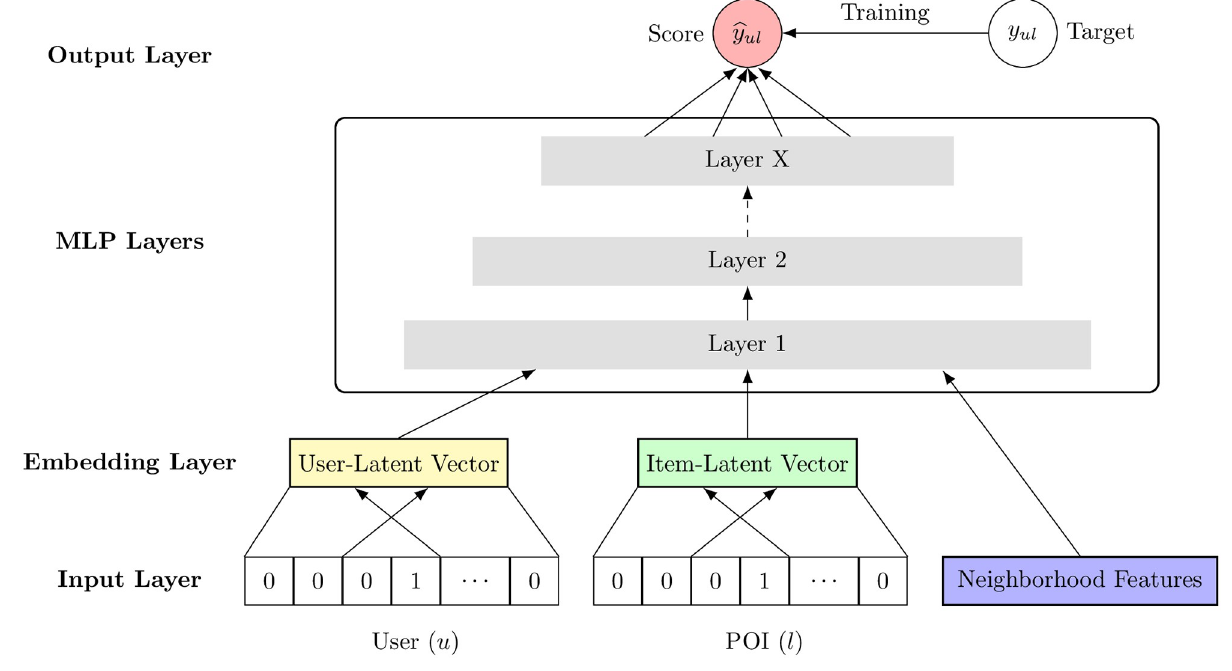
Fig 2. The architecture of the NbdMLP